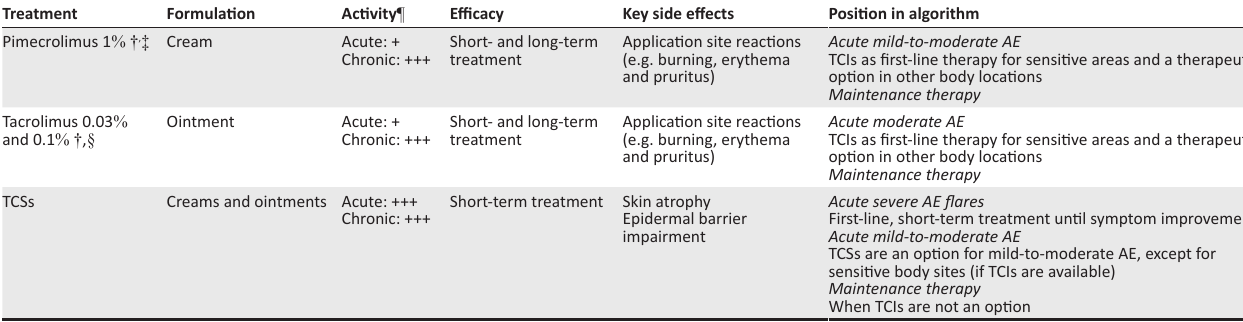
TABLE 1: Topical calcineurin inhibitors and topical corticosteroids. 68 Treatment